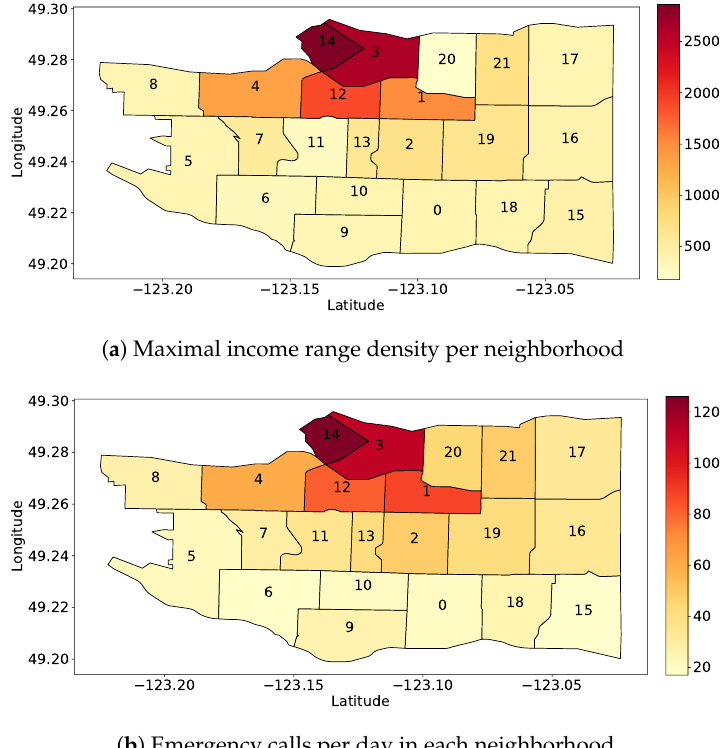
Figure 6. Heatmap of a sample of demographic ( a ) and socio-demographic ( b ) data at our disposals. These two samples look quite